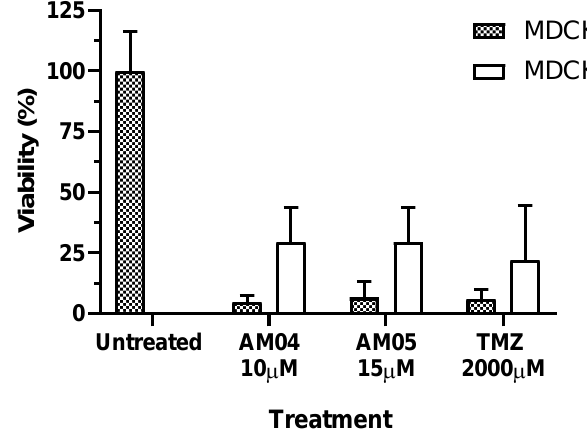
Figure 3. Evaluation of the cell membrane permeability of sesquiterpene lactone AM04 (goyazensolide), AM05 (lychnofolide) and temozolomide (TMZ) and untreated U87MG cells through a mimic membrane assay formed by monolayer of MDCK cells. Results are expressed in mean ± SEM, n = 3. For comparative analysis between untreated sample versus compounds tested with and without MDCK cell mimetic membrane, the paired Student’s t -test with one-tailed distribution was applied showing that all treatments were statistically significant p < 0.01.